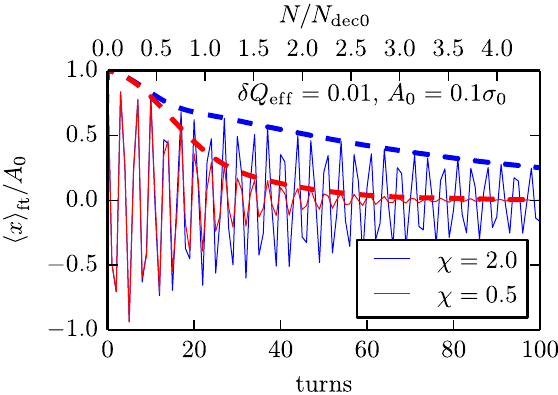
FIG. 2. Transverse decoherence of the kicked beams with space charge from the 2D simulations. The solid lines are the beam offsets and the dashed lines are oscillation